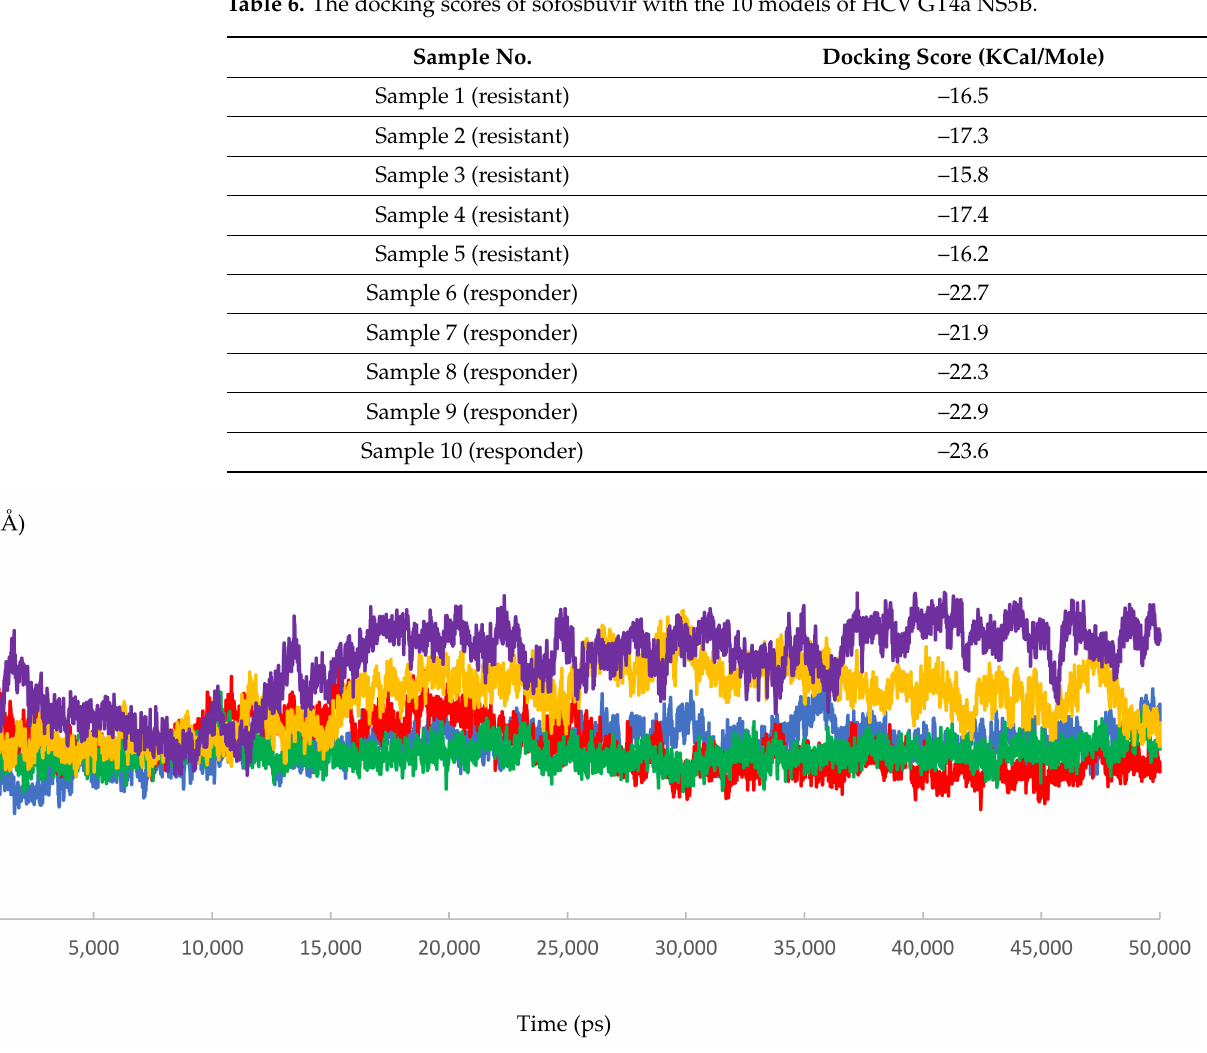
Figure 7. The RMSD of five dynamic simulation experiments for the HCV 4a NS5B responder samples. The green color represents sample 6, red represents sample 7, blue represents sample 8, yellow represents sample 9, and purple represents sample